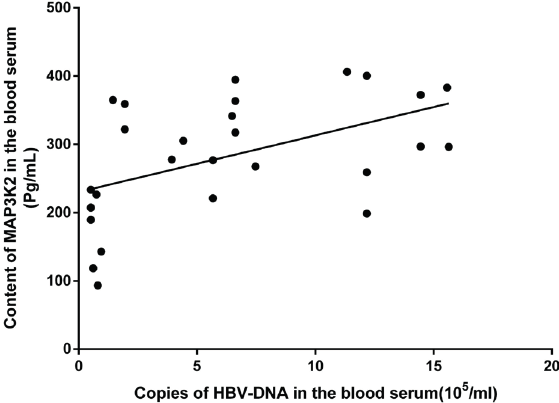
Figure 1 - Correlation analysis between content of MAP3K2 and copies of HBV-DNA. The figure shows that there was a positive correlation between the copies of HBV-DNA and MAP3K2 in serum (correlation index R 2 =0.251).